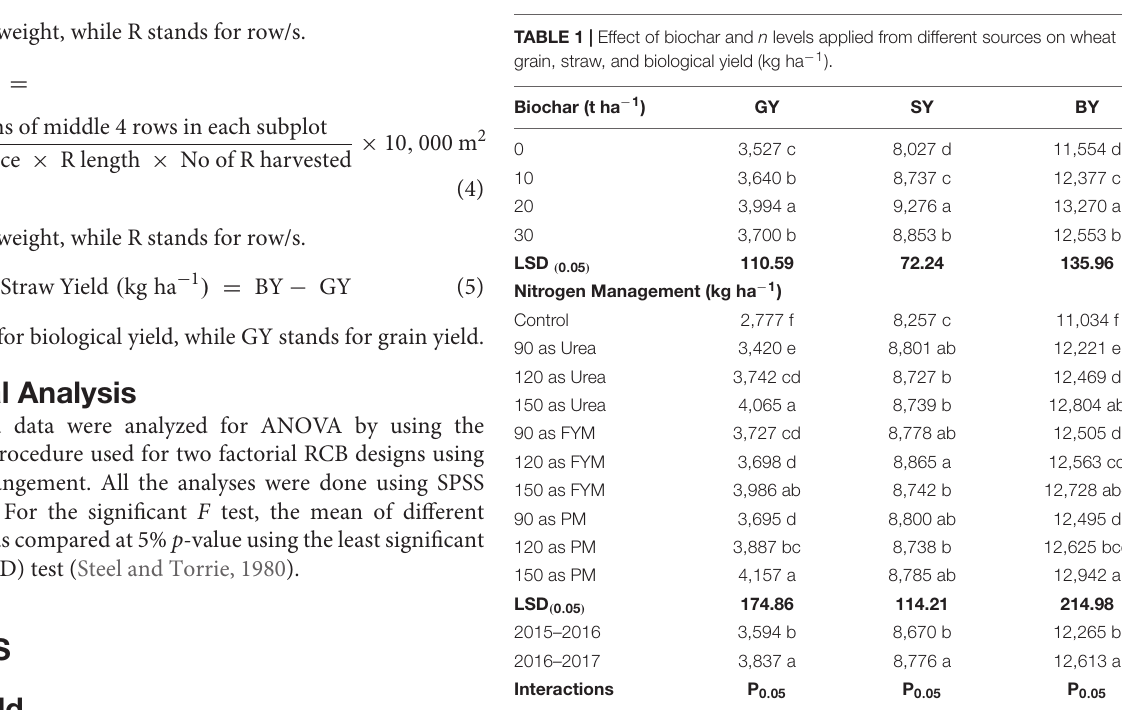
GY, grain yield, SY, straw yield; BY, biological yield; N, nitrogen; PM, poultry manure; FYM, farmyard manure. Values with different alphabets in each category are statistically different at 5%